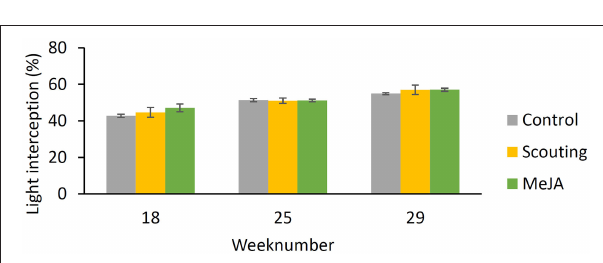
FIGURE 6 | Light interception (%) during the strawberry production phase as determined in weeks 18, 25, and 29. Data present mean ± SEM ( n =